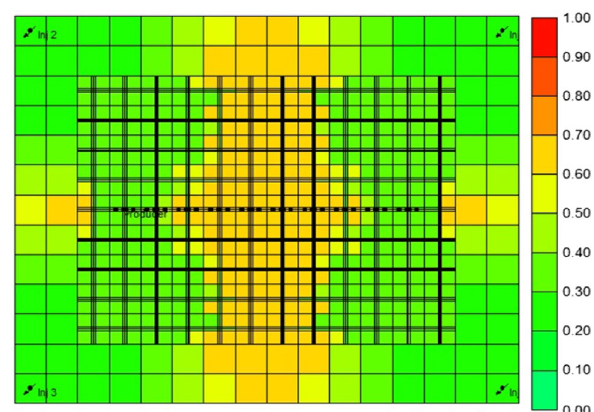
Fig. 7 Oil saturation distribution under steady condition after the pro- duction for 14 years